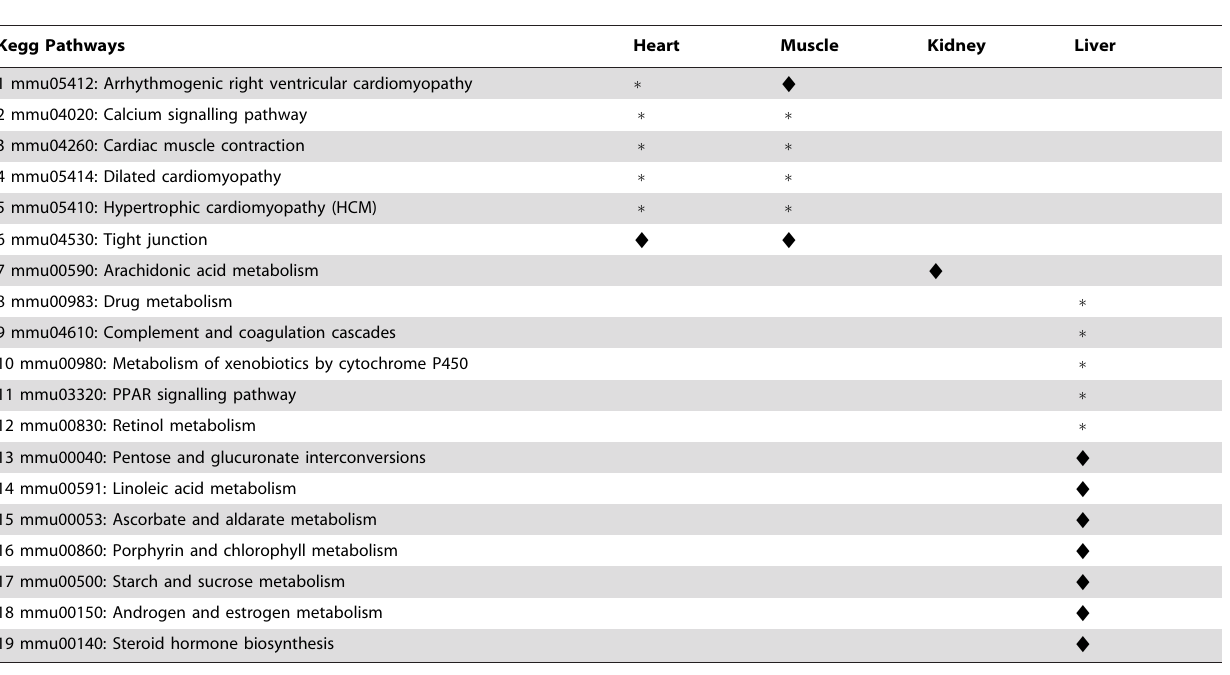
Kegg Pathways Heart Muscle Kidney Liver